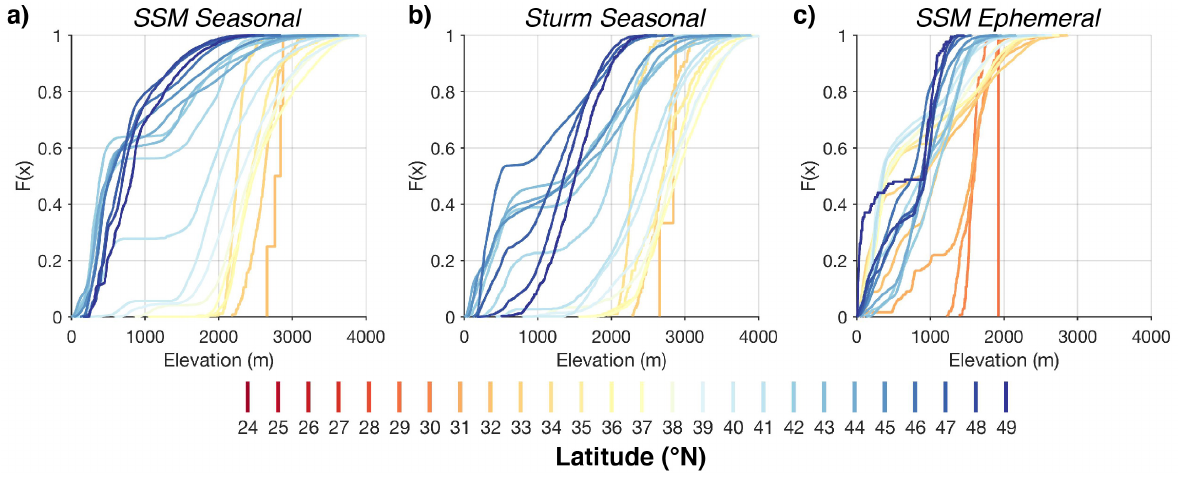
Figure 6. Cumulative distribution functions of snowpack classifications (requiring 10 years of snow observations) distributed by 1 ◦ latitude bins for: ( a ) Seasonal snowpacks defined by the snow seasonality metric (SSM); ( b ) Seasonal snowpacks defined by the Sturm method; ( c ) Ephemeral snowpacks defined by the snow seasonality metric